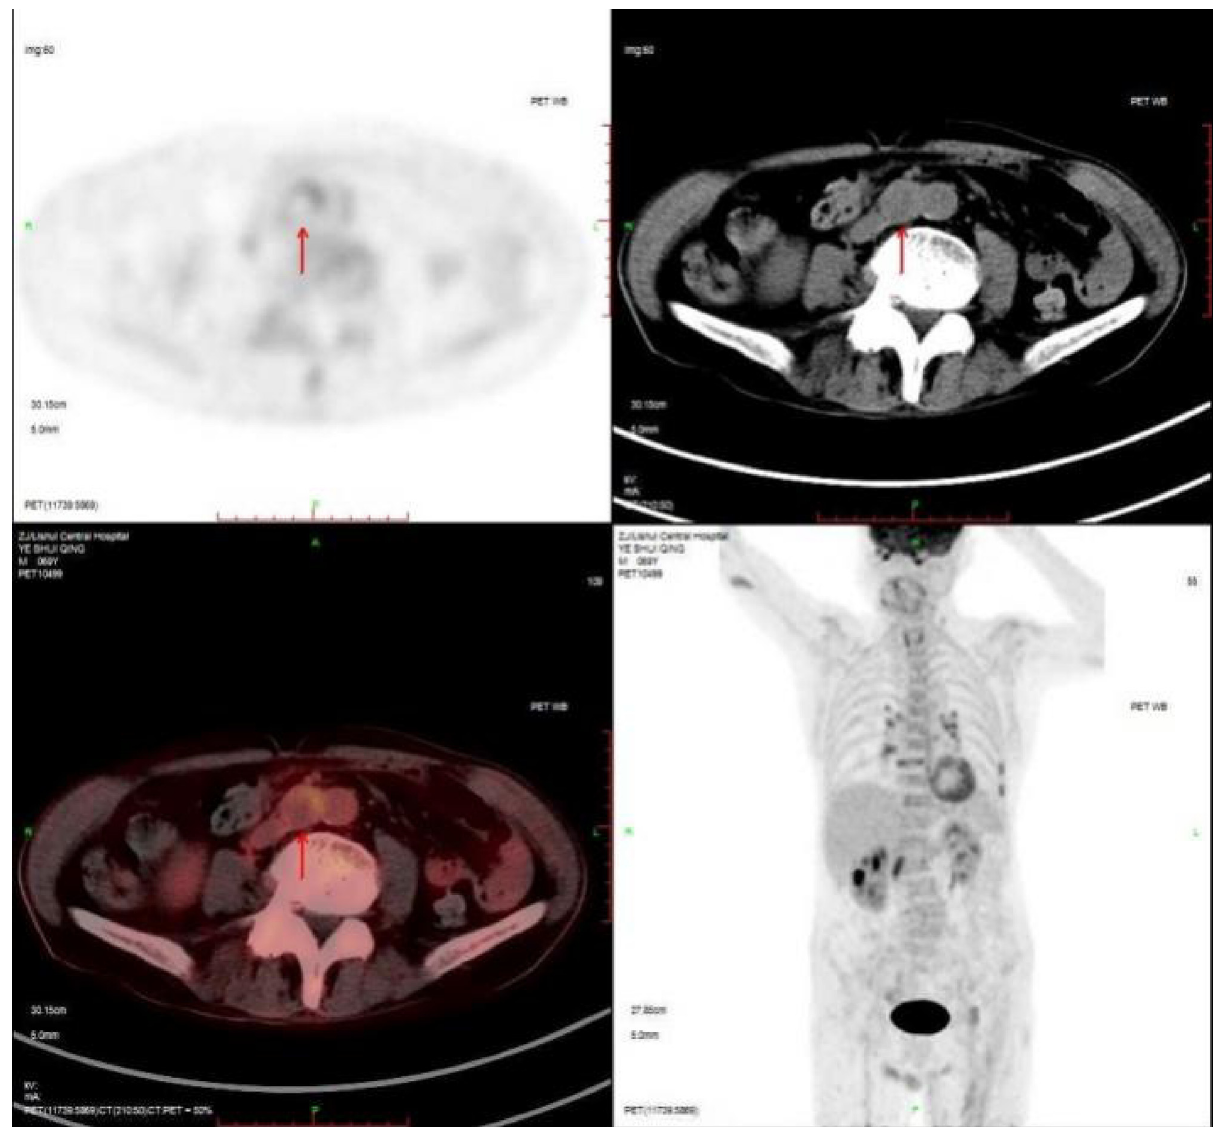
Figure 4: PET - CT scan revealed an isointense mass with a clear boundary near the abdominal aorta with mild uptake of the mass ( red arrow )